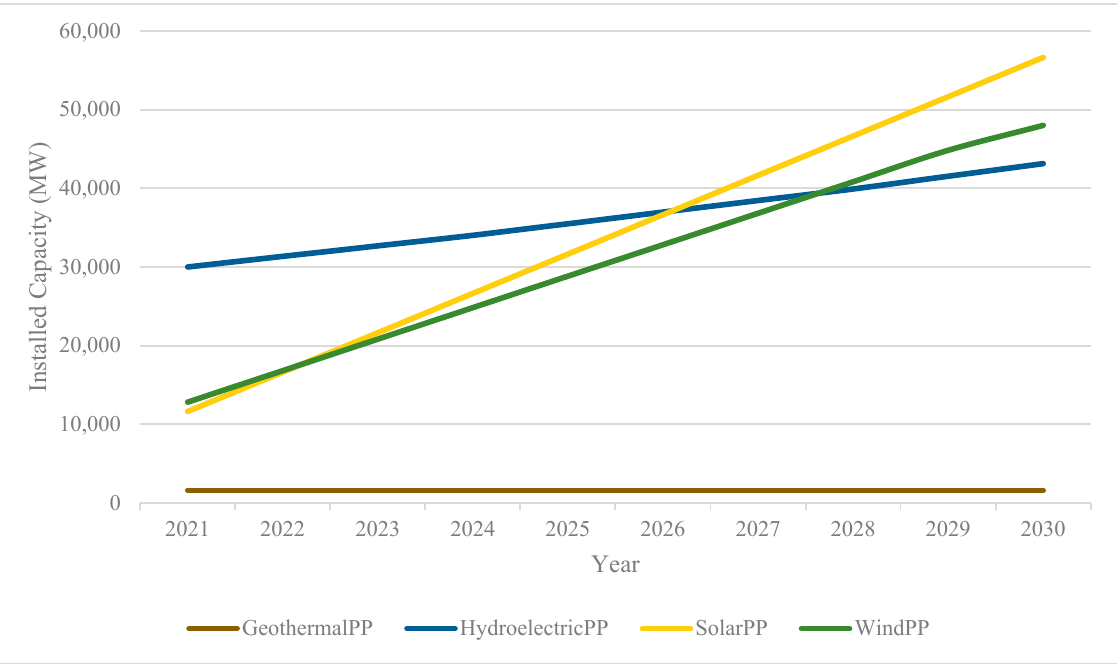
Figure 8. Installed capacities for the third scenario in the 2021–2030 horizon.